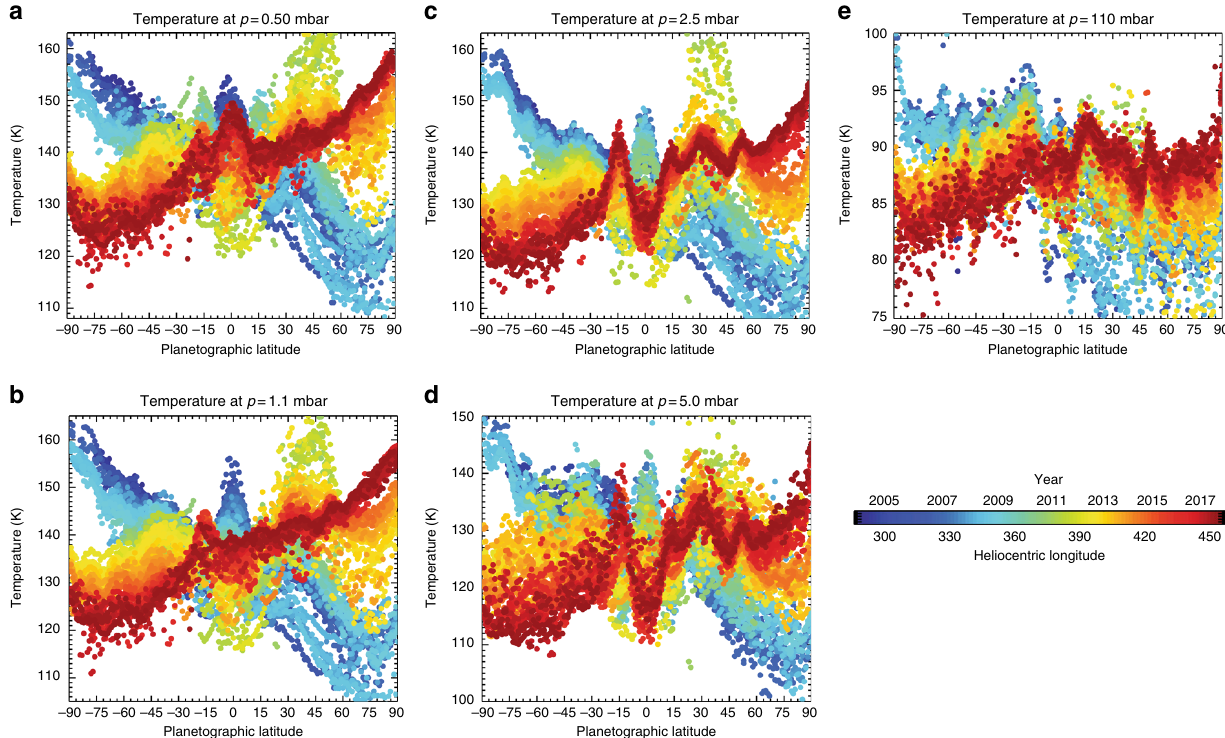
Fig. 3 Retrieved temperatures in the upper troposphere and stratosphere from the entire Cassini mission. Temperatures are displayed at fi ve pressure levels: a 0.5 mbar, b 1.1 mbar, c 2.5 mbar, d 5.0 mbar, and e 110 mbar. Colours refer to dates given by the legend. Saturn ’ s equatorial oscillation is observed at low latitudes 58 , the effects of the Great Northern Storm are visible at northern mid-latitudes 61 and the reversal of the stratospheric temperature asymmetry is most evident at the poles (this work)